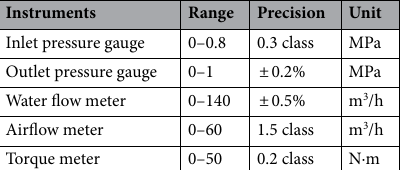
Table 3. Main performance indicators of the instruments.